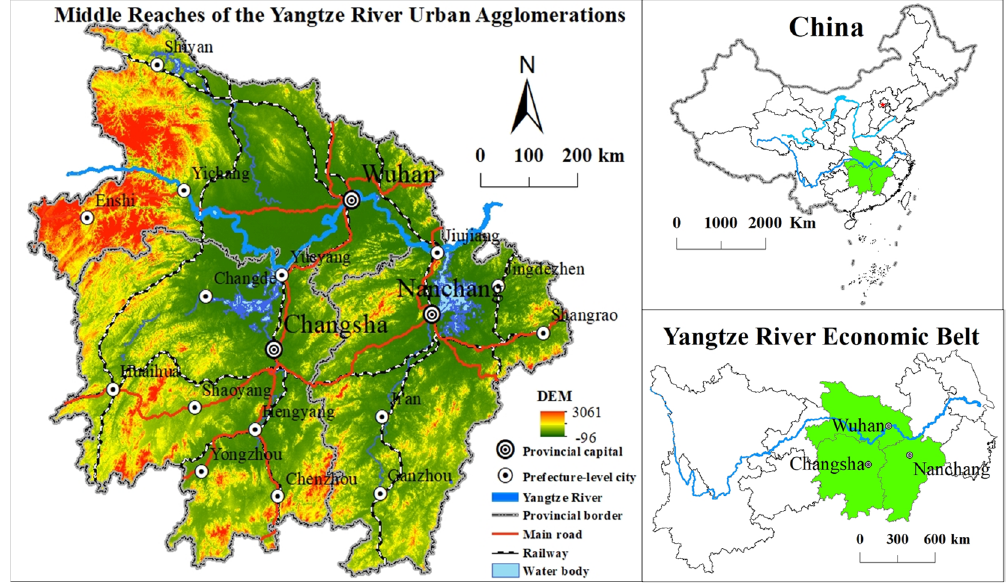
Figure 1. Location of the MRYRUA in